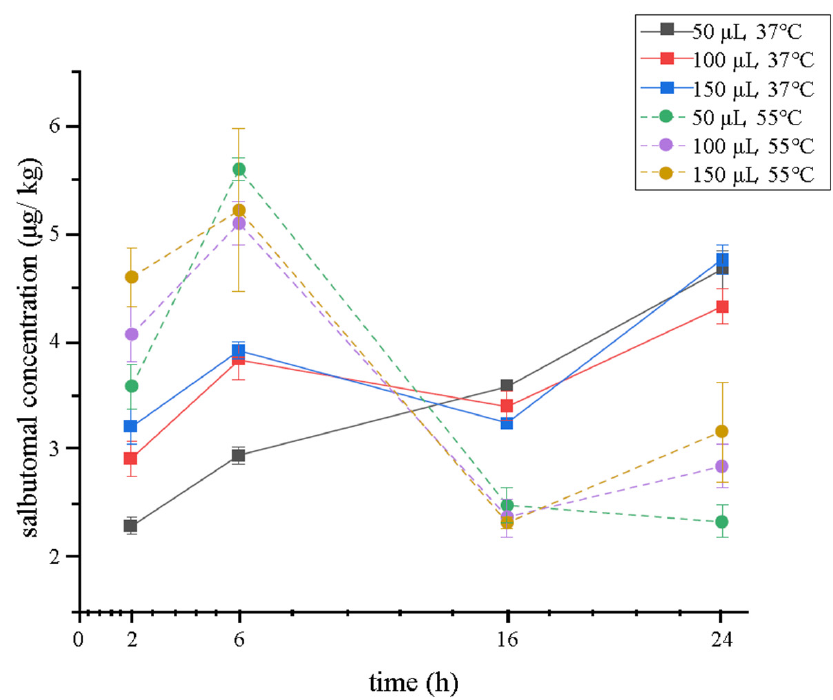
Figure 2. Salbutamol concentration when a different volume of β -glucuronidase/arylsulfatase was used under 37 °C or 55 °C ( n = 3).